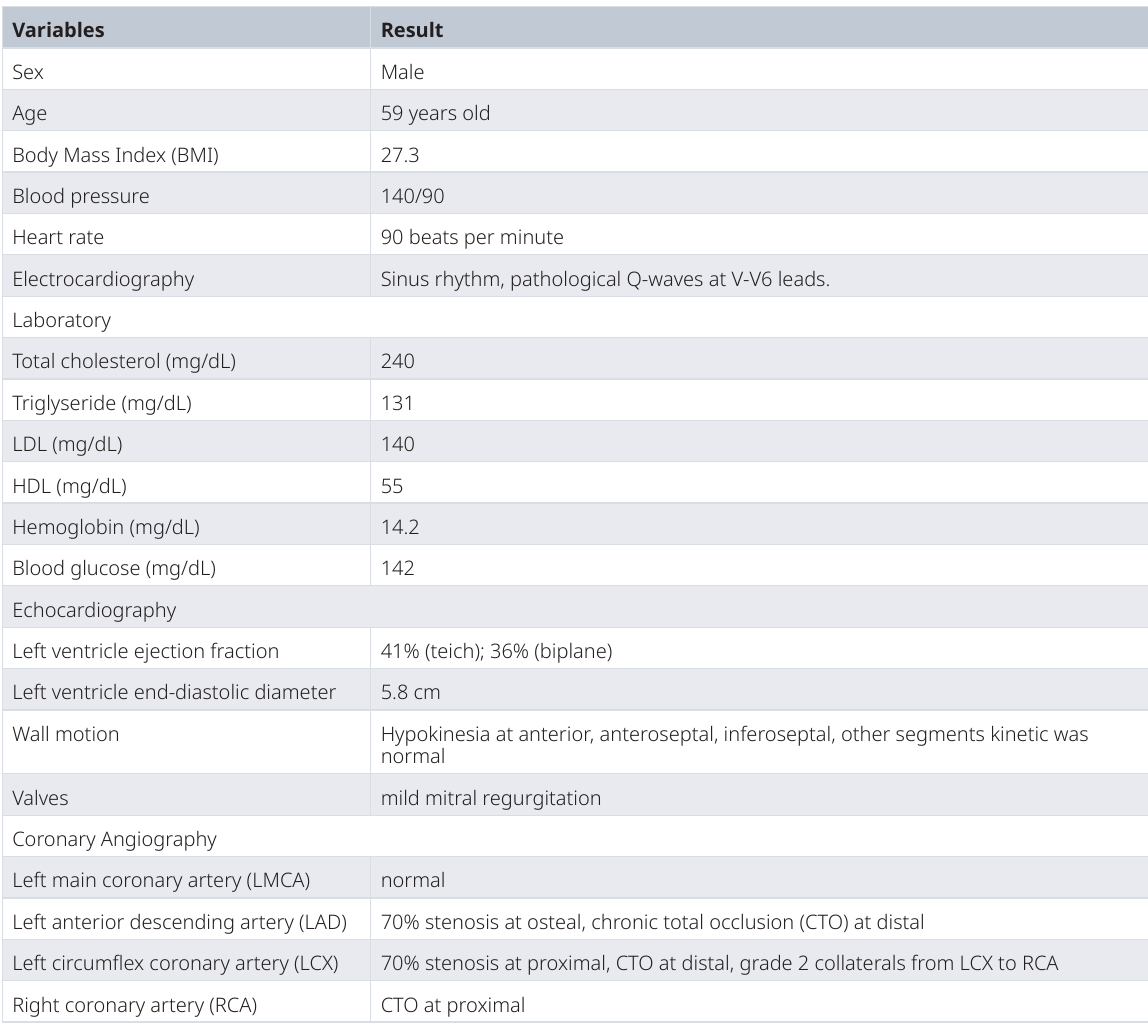
Table 1. Characteristics of the